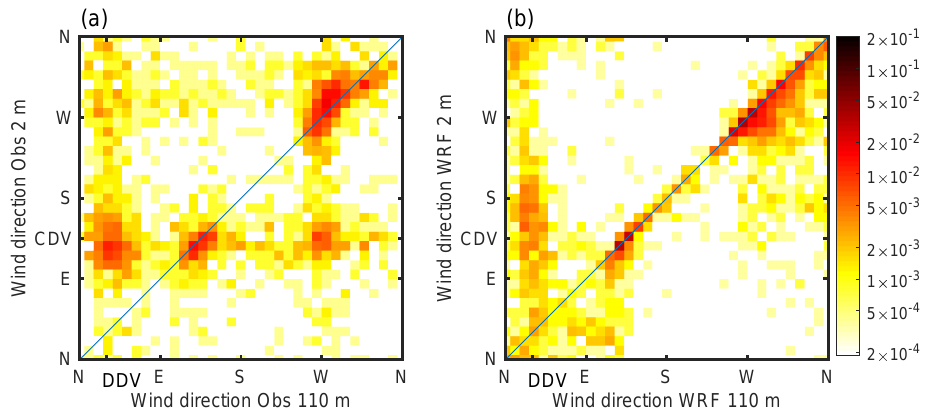
Figure 6. Probability density showing the comparison between 2 m and 110 m wind direction in ( a ) observations (same as Figure 3) and ( b ) WRF. CDV indicates the Cadarache downvalley direction and DDV the Durance downvalley direction.